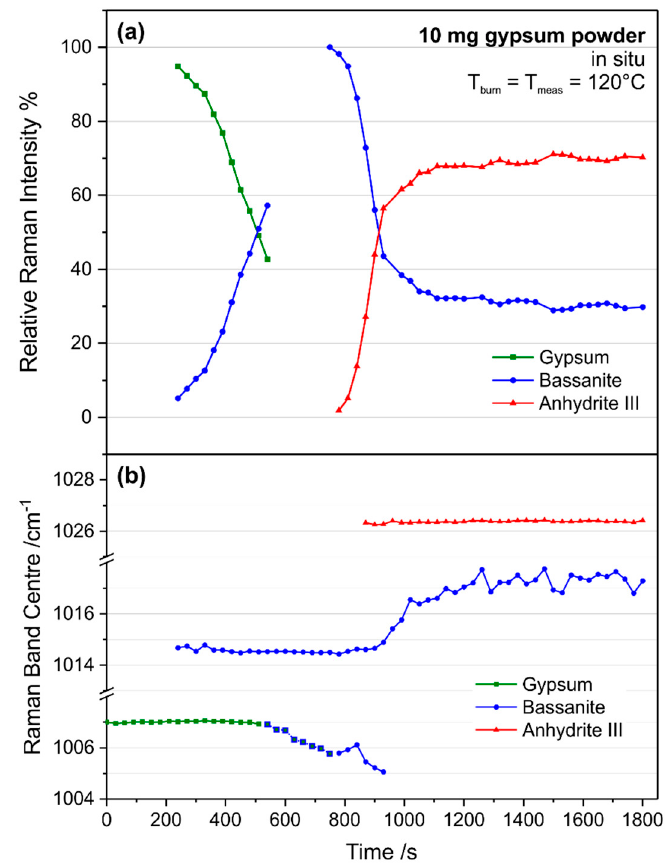
Figure 8. Temporal development of ( a ) relative Raman Intensities and ( b ) Raman band positions during burning of 10 mg gypsum powder at a constant temperature of T burn = T meas = 120 °C.